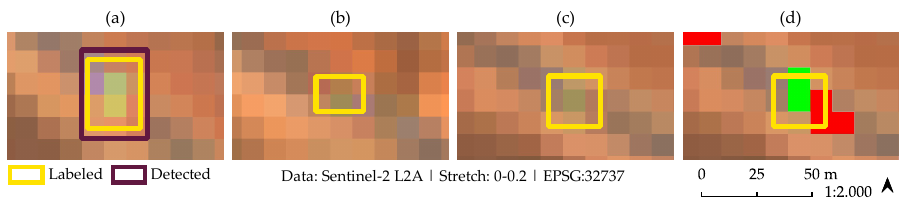
Figure 18. Detected and labelled example in Kenya: ( a ) True positive. ( b ) False negative. ( c ) False negative. ( d ) False negative and underlying RF